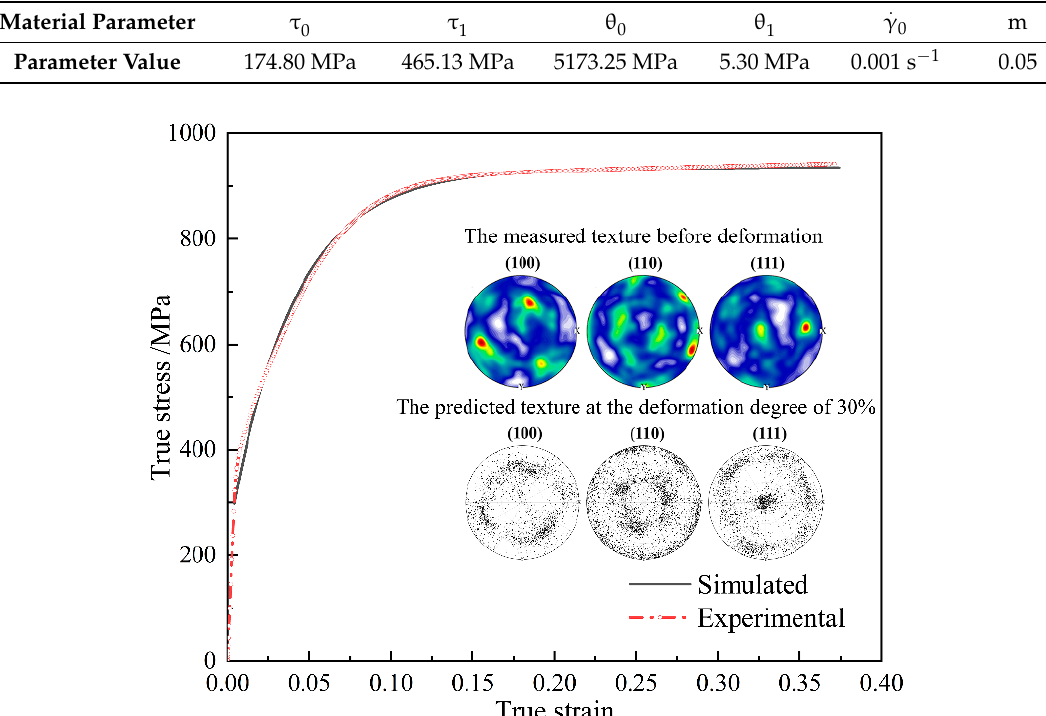
Table 1. Material parameters of the adopted NiTi shape memory alloy used in VPSC model.